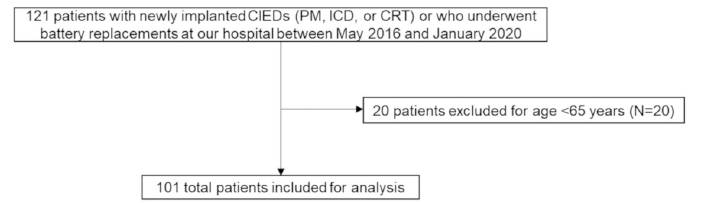
Fig 1. Flowchart showing the selection of the study population. CIED = cardiac implantable electrical devices; PM = pacemaker; ICD = implantable cardioverter defibrillator; CRT = cardiac resynchronization